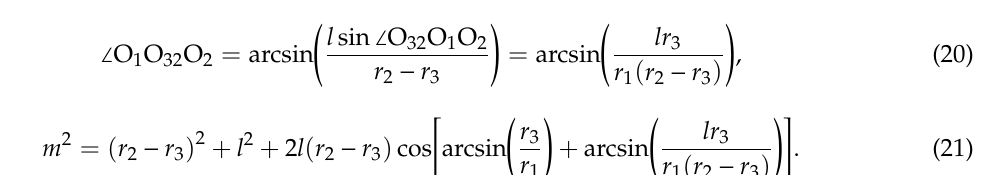
Figure 9. The kinematic analysis of the unlocking process of the low-power holding mechanism.